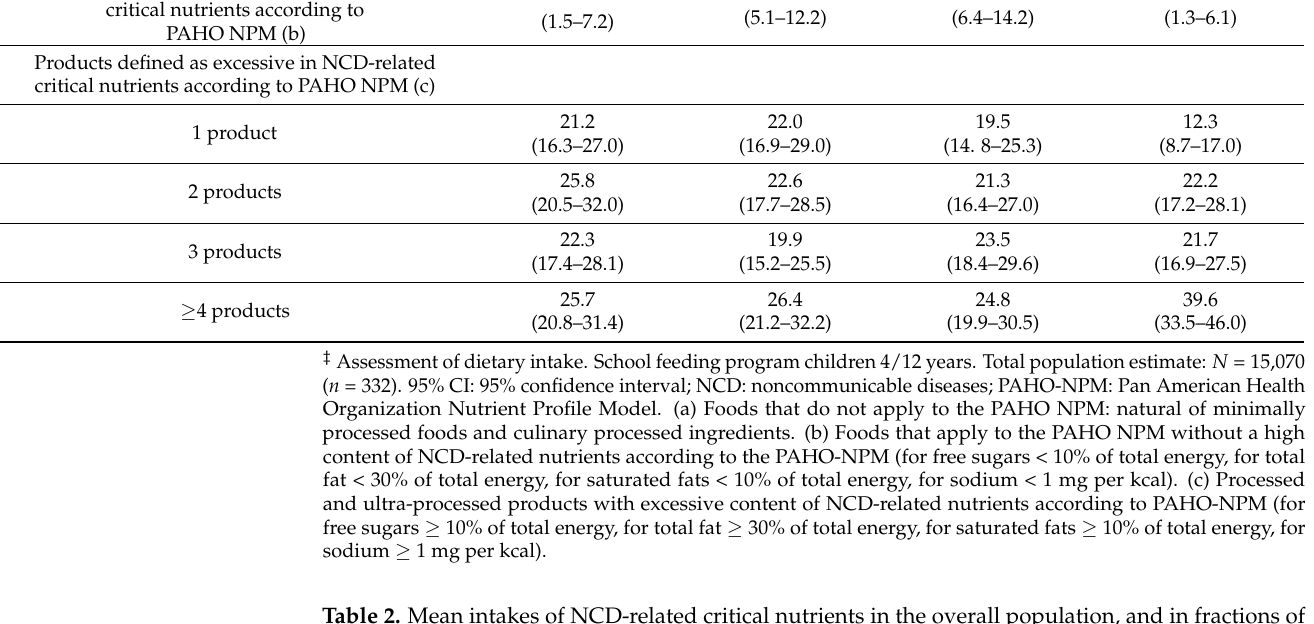
Table 2. Mean intakes of NCD-related critical nutrients in the overall population, and in fractions of the population consuming products with and without an excessive content in NCD-related